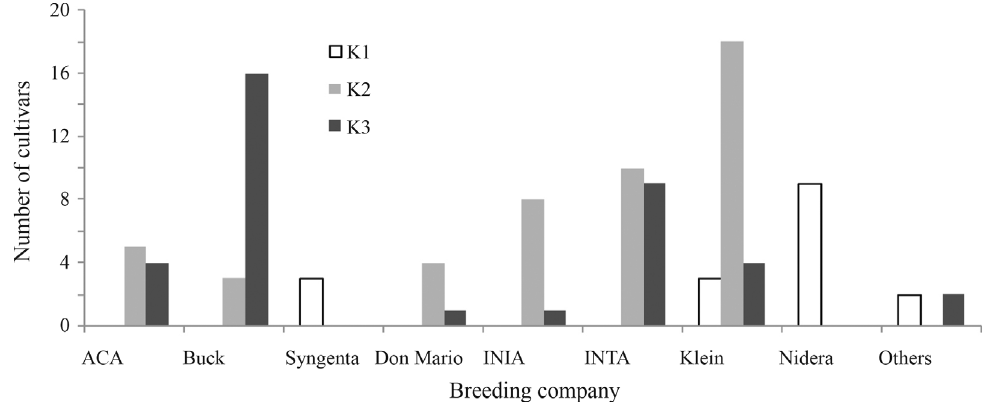
Figure 3 - Bar chart representing the frequency of cultivars belonging to each breeding company distributed in the subpopulations K1 to K3.